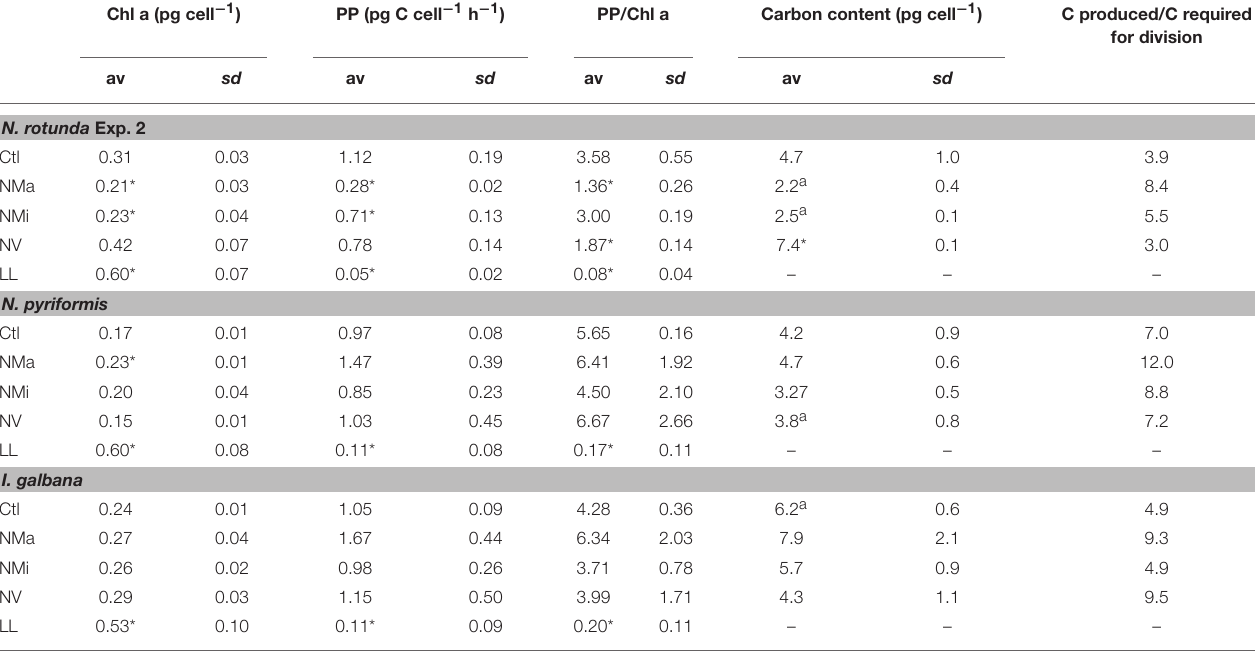
TABLE 3 | Cellular primary production (PP), cellular Chl a concentration, PP/Chl a and cellular C content for the 3 algal strains. Chl a (pg cell − 1